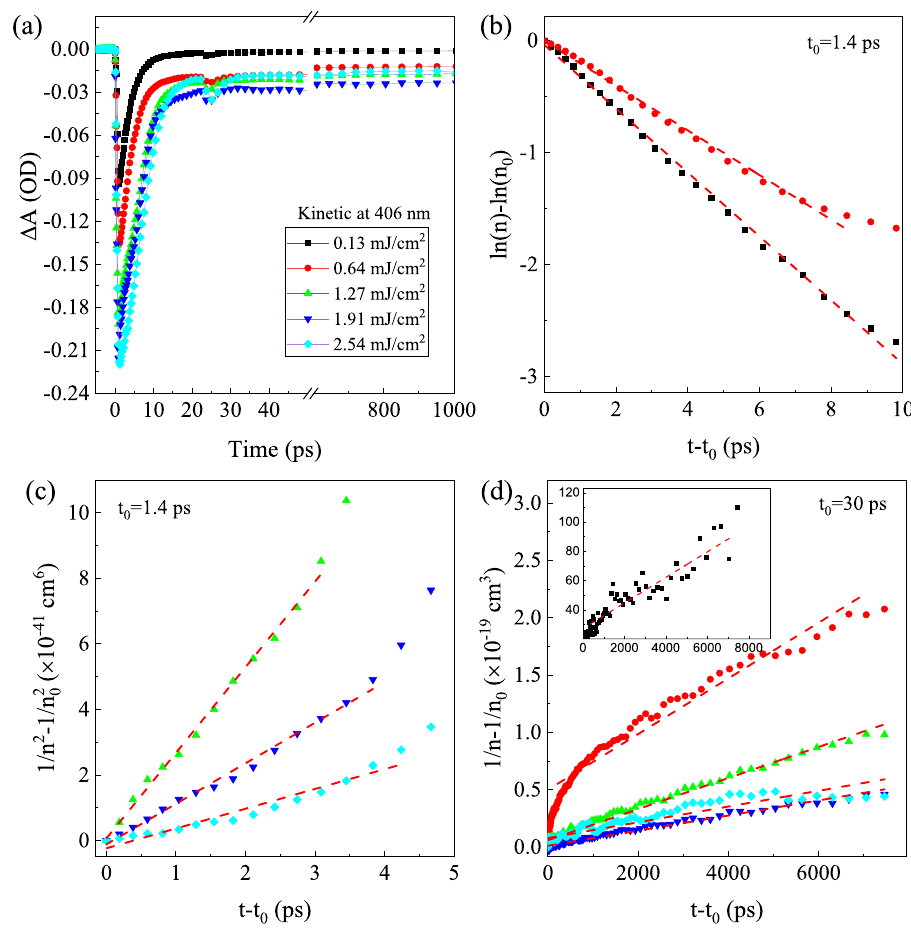
Fig. 5 | Analysis of recombination kinetics. a Kinetic at 406nm with different pump fl uence. b ln n ð Þ (cid:2) ln ð n 0 Þ vs. ð t (cid:2) t 0 Þ . c 1 = n 2 (cid:2) 1 = n 2 0 vs. ð t (cid:2) t 0 Þ , and d 1 = n (cid:2) 1 = n 0 vs. ð t (cid:2) t 0 Þ withdifferentpump fl uences,withtheinsetcorresponding to this plot under 0.13mJ/cm 2 . The red dash lines represent their linear fi ts. In